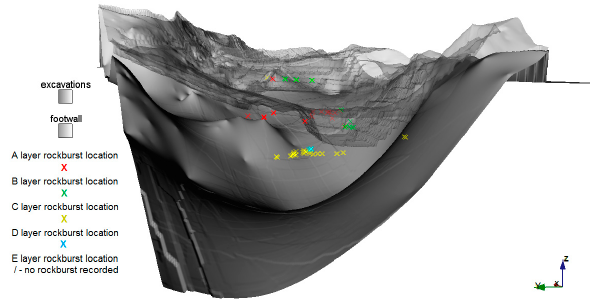
Figure 8. Visualizations of general situation of coal burst source locations in individual thickness layers A–E.